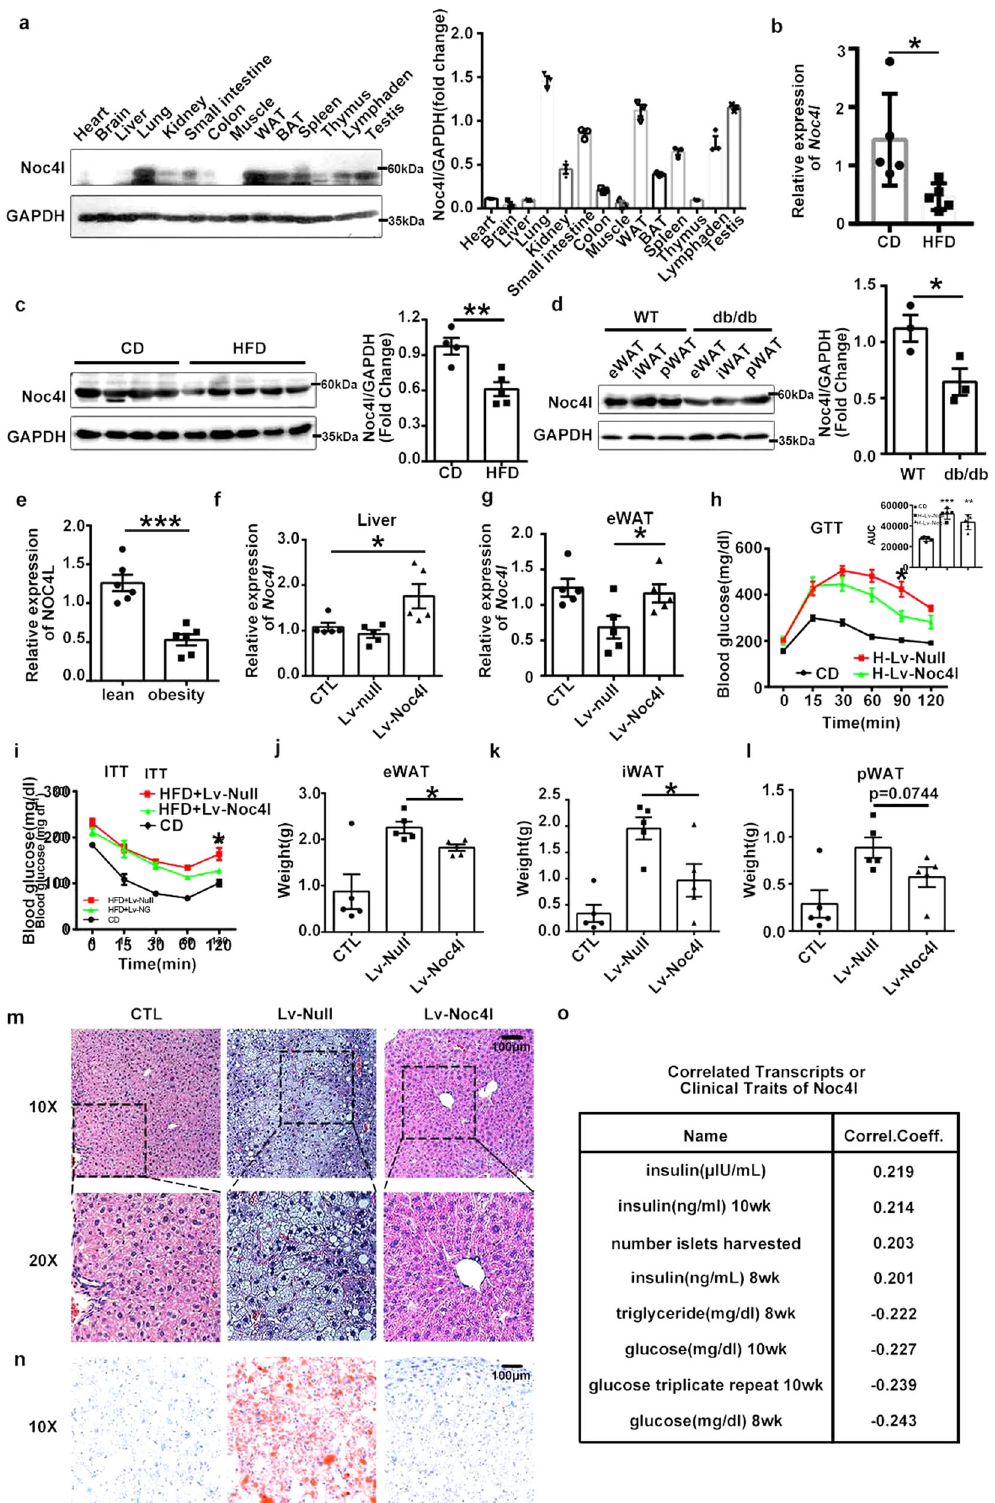
were signi fi cantly increased in the HFD-fed Noc4l LKO mice (Fig. 3c). Accordingly, Noc4l deletion in macrophages led to metabolic abnormalities in mice. Histopathological analysis of pancreas and the insulin secretion of the islet were no different between the Noc4l fl / fl and Noc4l LKO mice (Supplementary Fig. 1k, l), indicating that Noc4l exerted no effect on the function of the